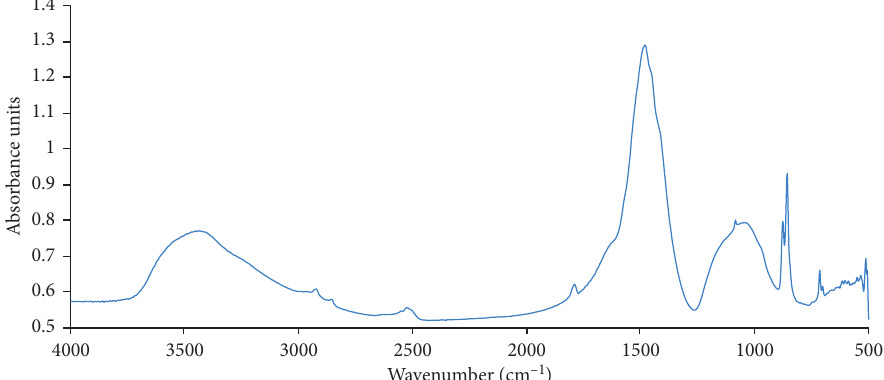
Figure 7: FTIR spectra for concrete sample C80S20 after 28 days of curing.